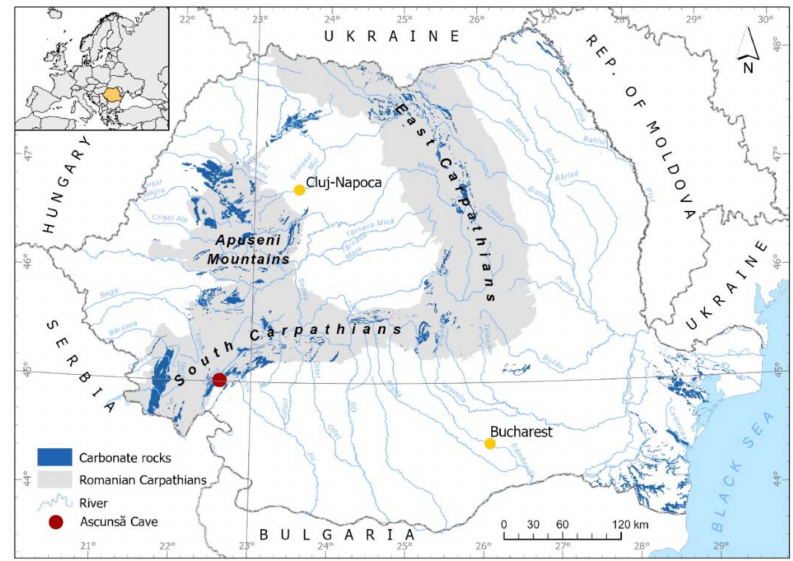
Figure 1. Location of study area modified from B ă descu & Tîrl ă [27].